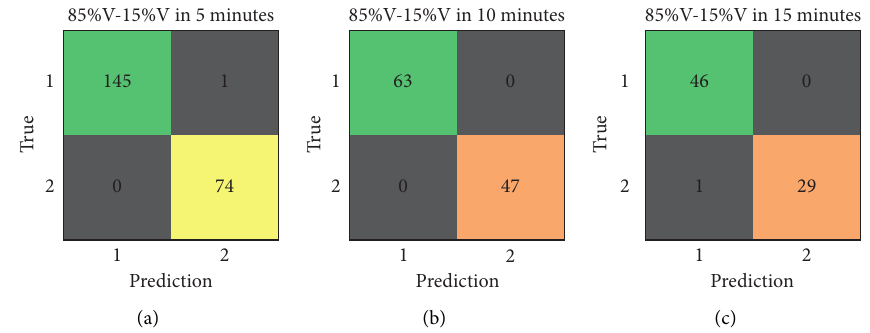
Figure 3: Illustration of the confusion matrix of testing data of 85%V–15%V in different periods.